Question: What does this figure show? Answer in one sentence.
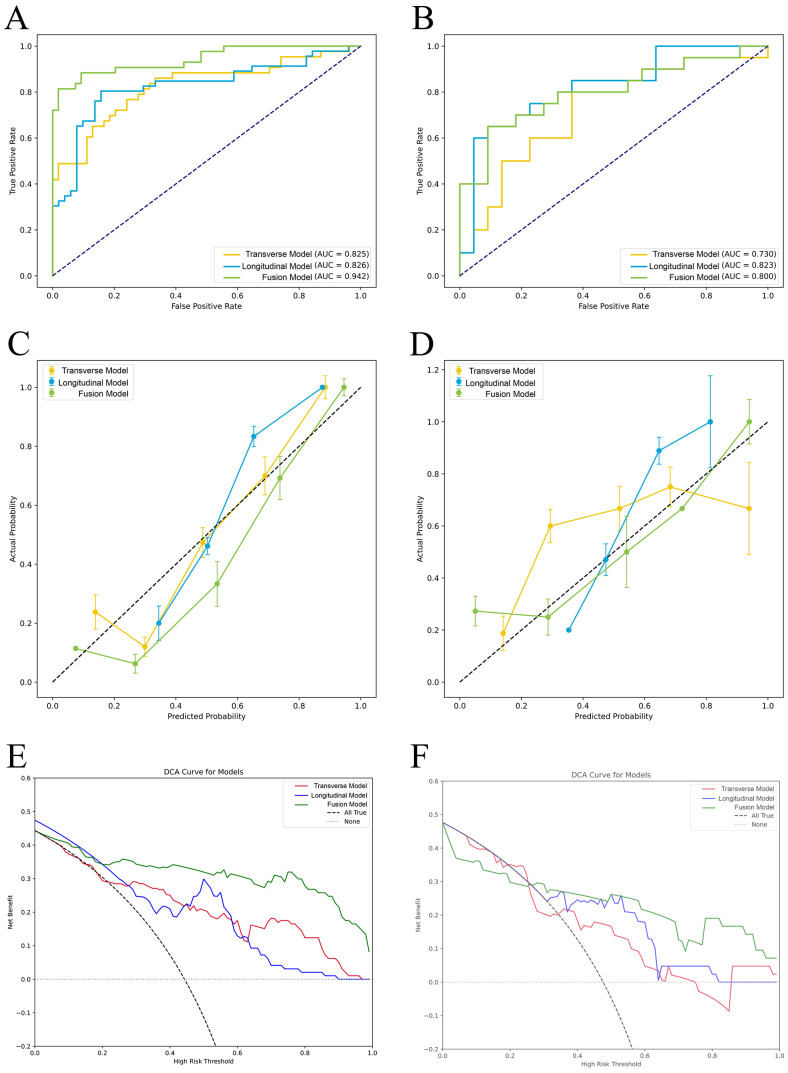
Answer: Evaluation of the logistic regression models based on receiver operating characteristic curve analysis (A, B) , calibration curves (C, D) , and decision curve analysis (E, F) , in the training dataset (left) and validation dataset (right).